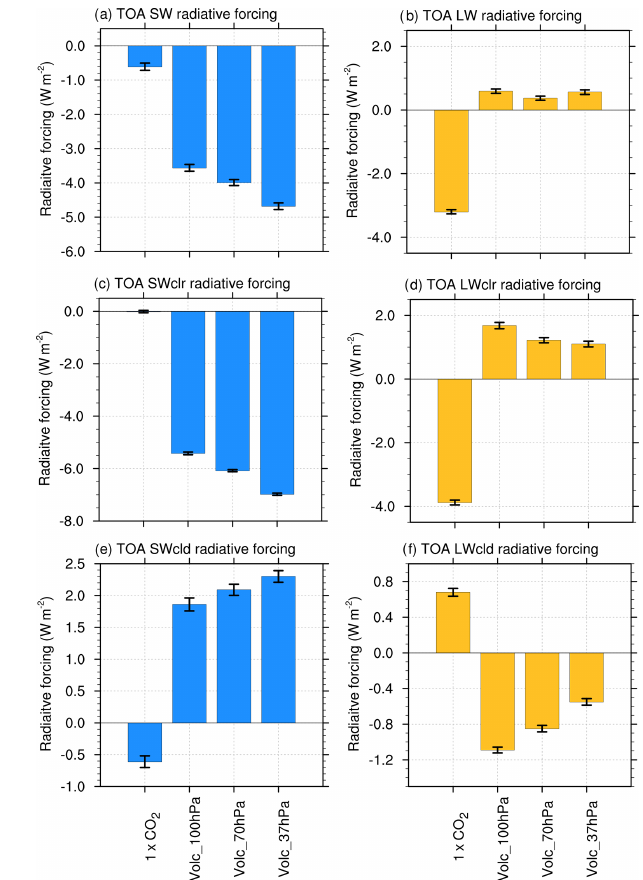
Figure 3. TOA SW and LW radiative forcing for all-sky (a, b) clear- sky (c, d) and cloudy-sky (e, f) conditions relative to the 2XCO2 ex- periment, estimated using the two-point method (Sect. S1). The er- ror bars represent 2 standard errors calculated from 30 annual means of the difference from the 2XCO2